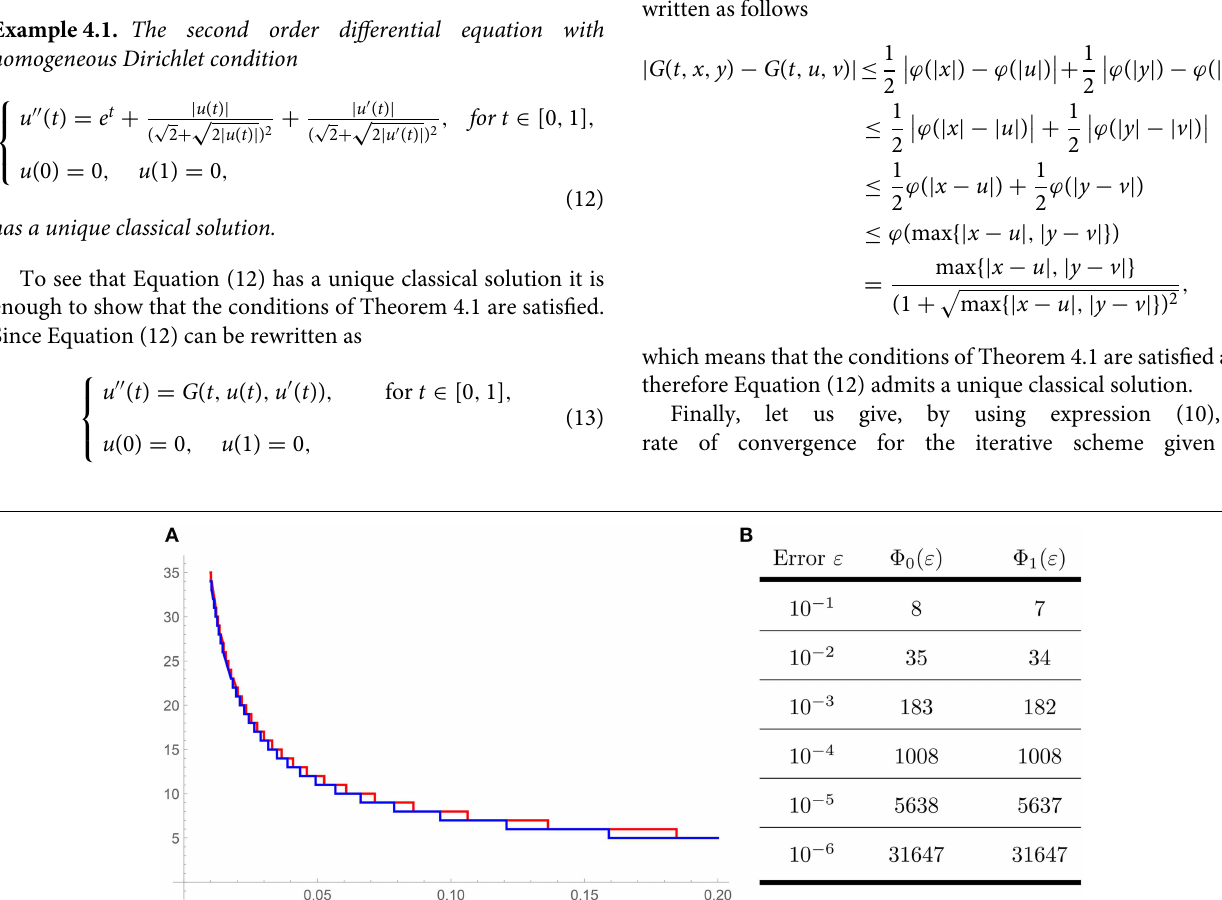
t 2 t . (B) (The ratio of convergence 8 0 = −